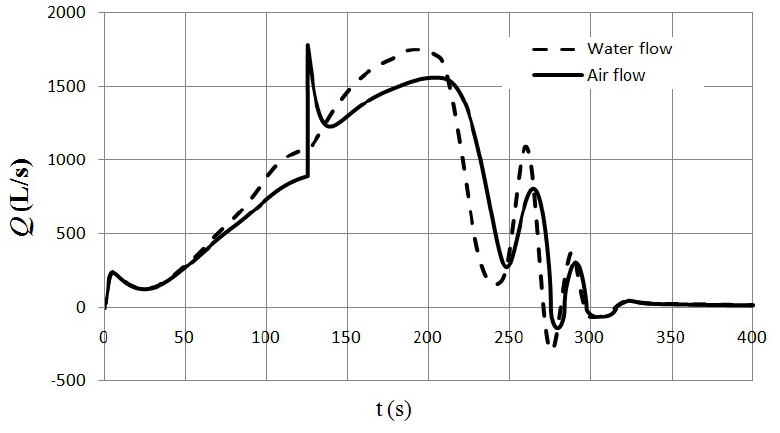
Figure 8. Evolution of the water and air flow in emptying column